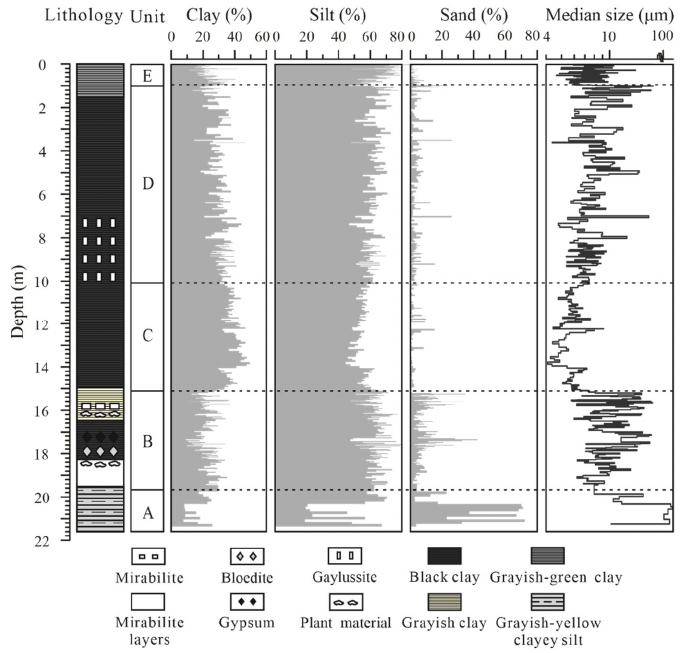
Figure 3. Variations in grain ‐ size compositions and median size of core AGL ‐ 2010.